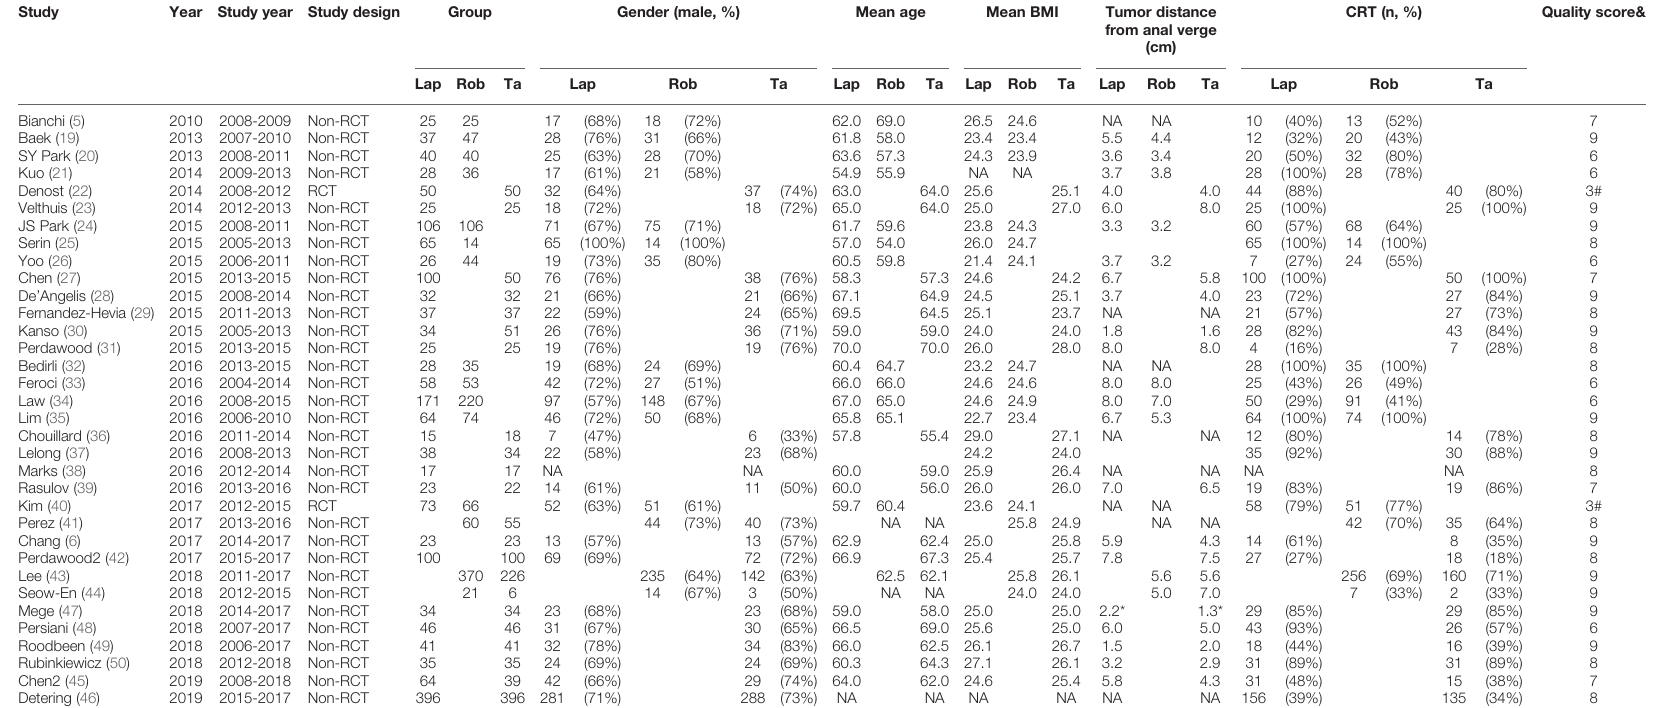
TABLE 1 | Characteristics of included